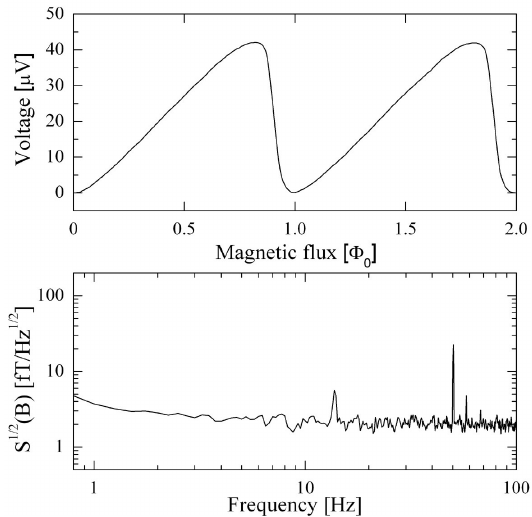
We report here the voltage as a function of the magnetic flux (V- Φ ) ( top ) and magnetic field noise spectral density ( bottom ) measured at T = 4.2 K for a SQUID magnetometer. The 1/f corner is less than 3 Hz, which is essentially due to the low frequency noise of the amplifier. The peak at 50 Hz is due to the power